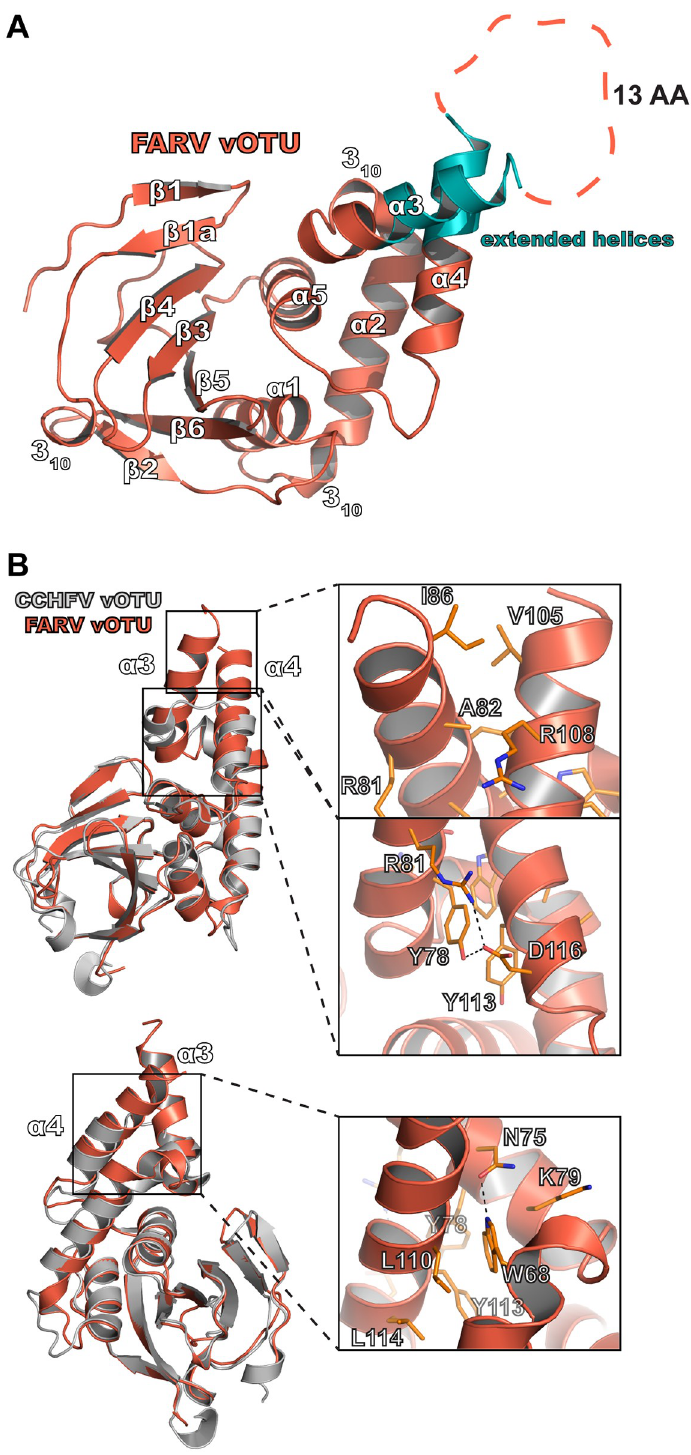
Fig 6. Structure of the FARV vOTU. (A) Overall structure of the FARV vOTU with the secondary structure denoted based on DSSP. The extended regions of the α 3 and α 4 helices are colored in teal. Intervening amino acids lacking electron density are represented by an orange dashed line. (B) Molecular features of the extended α 3- α 4 helices of FARV vOTU, with CCHFV vOTU included for comparison. Atom pairs within hydrogen bonding distance are denoted by black